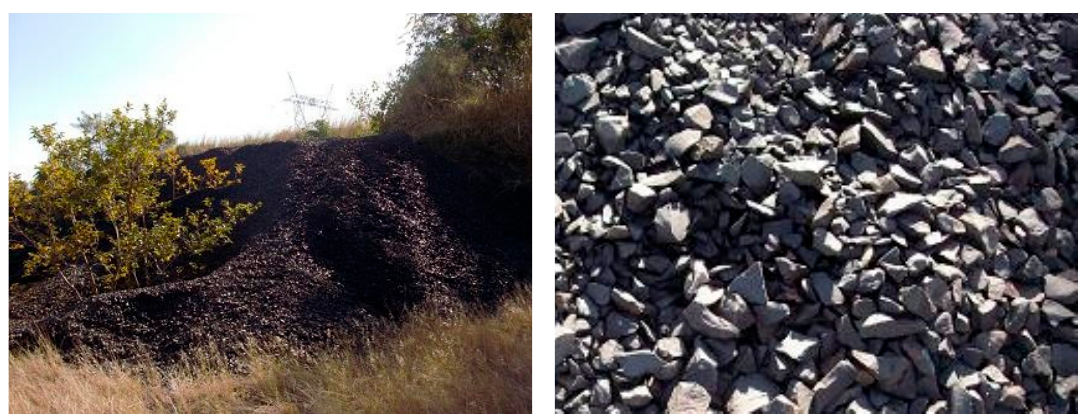
Figure 1. Quartzite deposit.